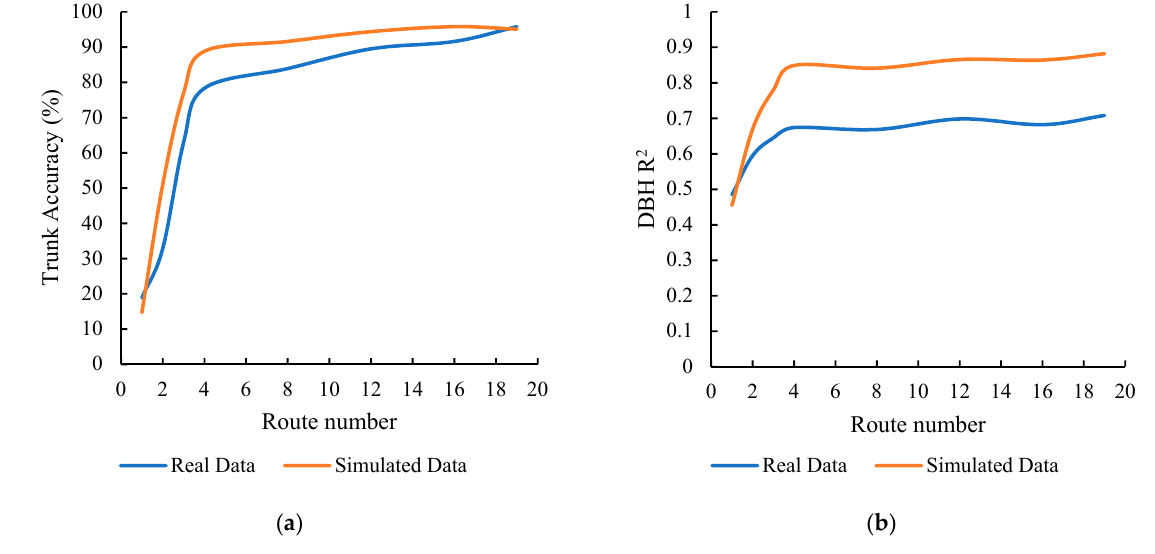
Figure 10. Variation curves of trunk point and DBH extraction accuracies for different scanning angles in quadruple-routes mode. ( a ) Real data; ( b ) simulated data.